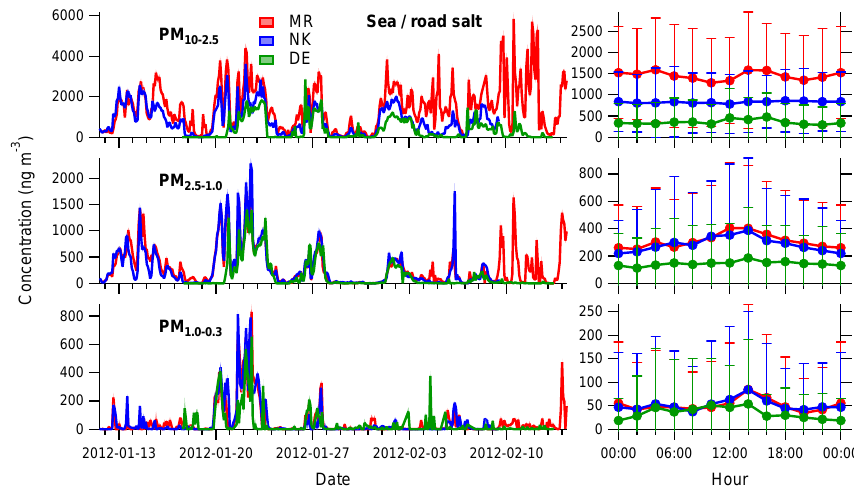
Figure 8. Time series (left) and diurnal variations (right) of the sea/road salt factor at MR, NK and DE for PM 10–2 . 5 , PM 2 . 5–1 . 0 and PM 1 . 0–0 . 3 . Time series show the mean of all good solutions ± 1SD as shaded areas. Diurnals show the mean of the time series ± 1SD as whiskers, with the hour being the start of a 2h sampling period (00:00UTC means sampling from 00:00 to 02:00UTC).